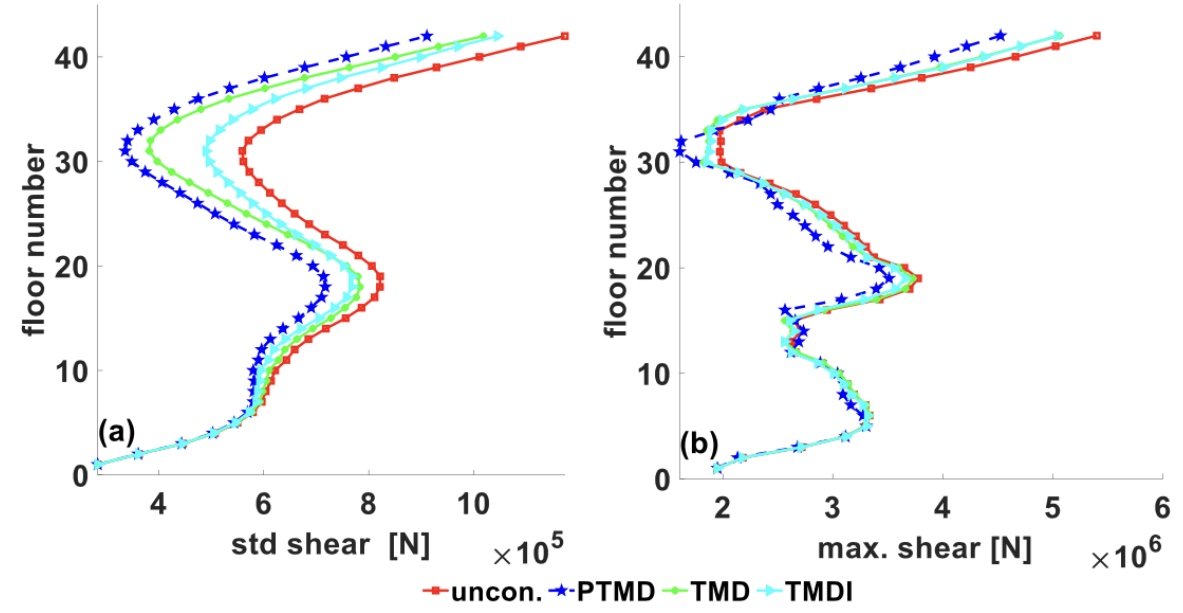
Figure 20. The floorwise shear force under El-Centro earthquake ground acceleration: ( a ) STD shear, ( b ) maximum shear.